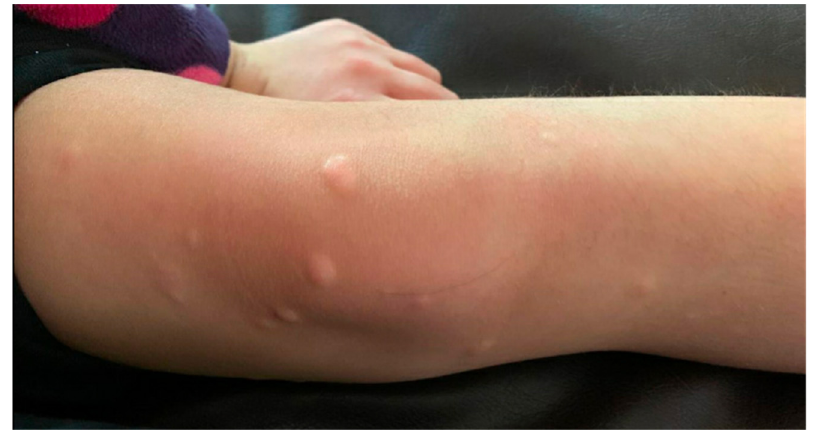
Figure 3. Right anterior knee skin-colored, firm papules and nodules.